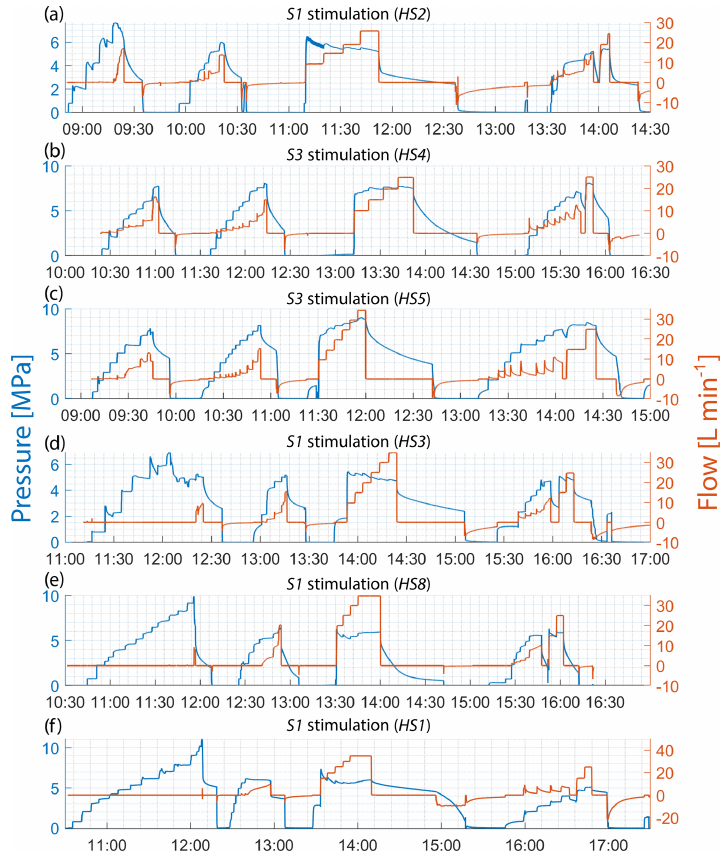
Figure A2. Injection protocols for all experiments. The tests are in chronological order.